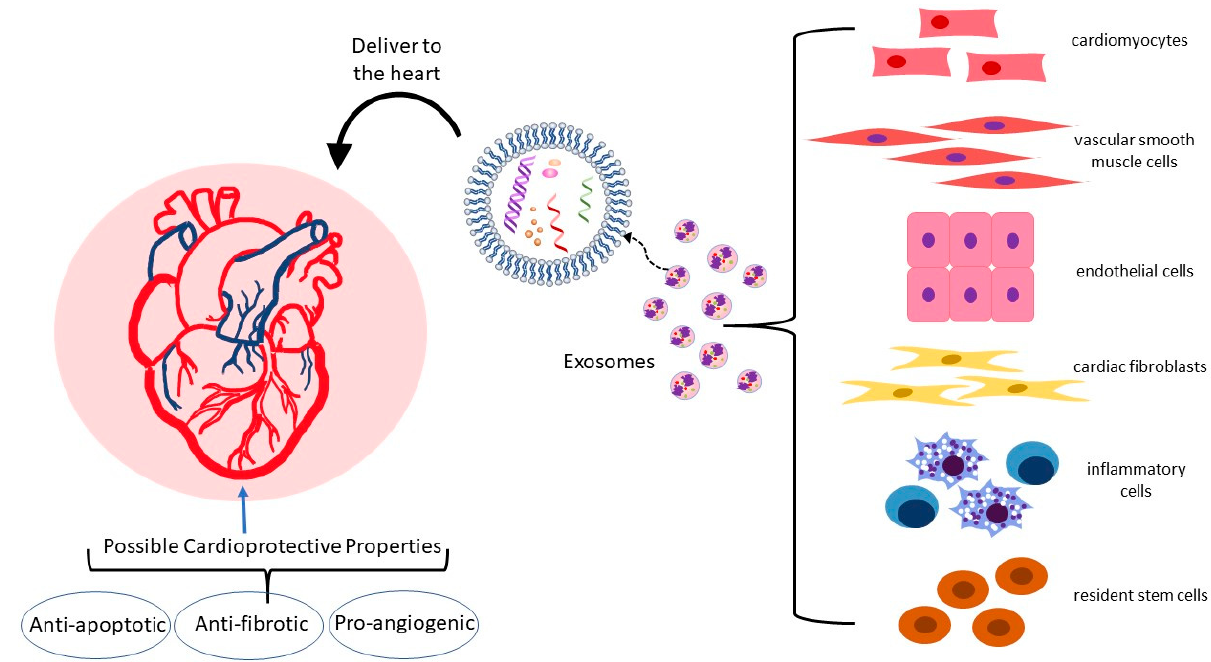
Figure 2. Exosomes and their cardioprotective potential. Exosomes derived from a variety of cell types can influence the heart via delivery of their RNA, DNA, lipid, and protein cargo. The exosomal contents can reach the heart via the bloodstream or directly through cell-to-cell contact and exert bene fi cial e ff ects on apoptosis, fi brosis, and angiogenesis. Exosomal HSP-27 release can also a ff ect macrophage cholesterol homeostasis [54,55]. HSP-27 is considered atheroprotective, and low levels of this protein in plasma are asso-